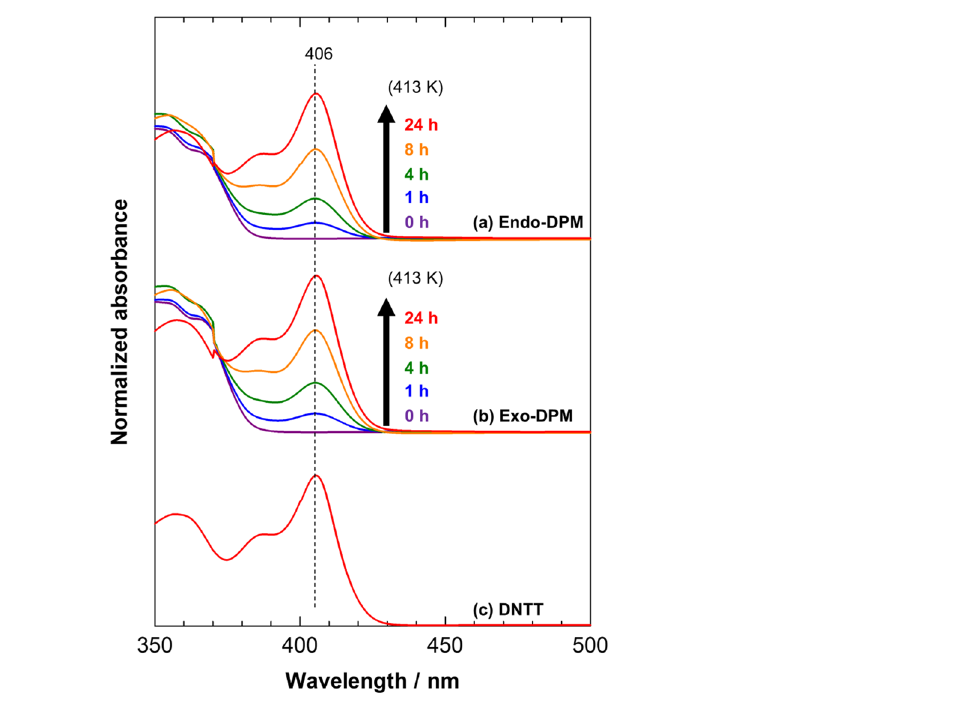
Figure 2. Annealing-time-dependent UV–Vis spectra of precursor solutions ( a , b ) and the reference spectrum of a DNTT solution ( c